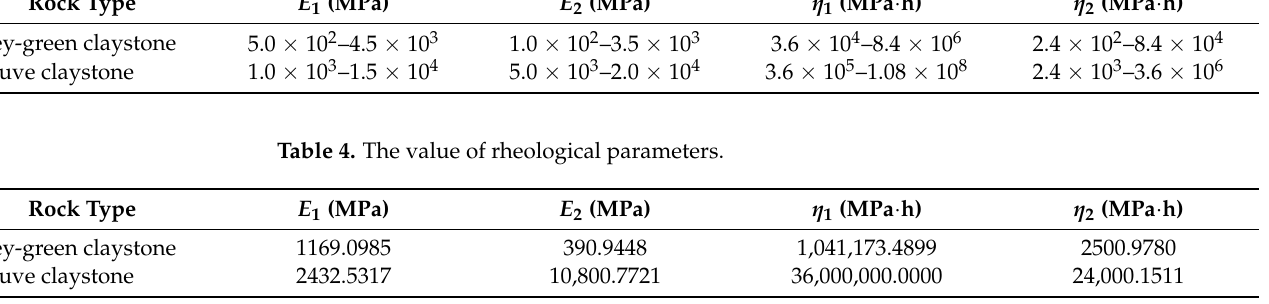
Figure 17. The predicted and testing data at 2.71 MPa stress level for mauve claystone. Table 3. The ranges of rheological parameters.